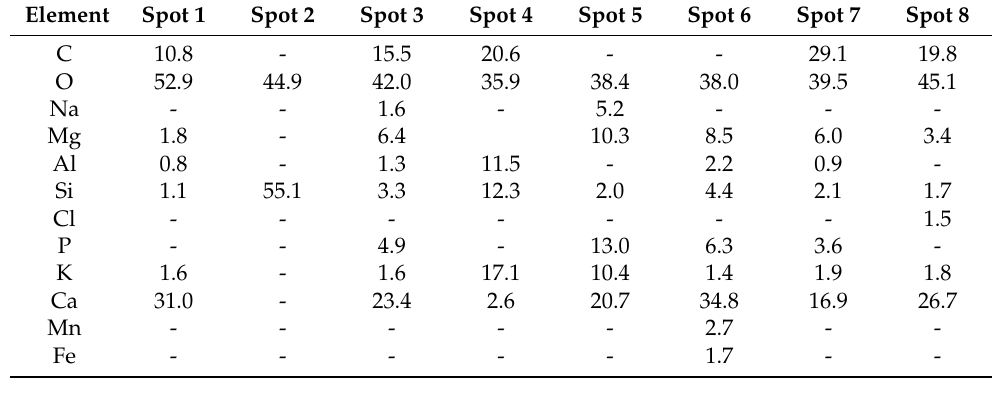
Table 7. Chemical elements detected in EDS spots of fly ash sieved with 63 µm (by weight %). Element Spot 1